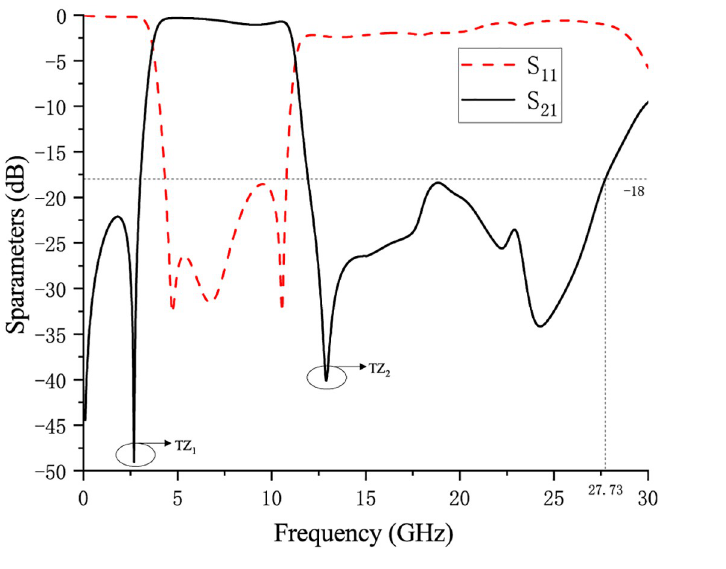
Fig 10. S 21 simulation curve of UWB BPF.